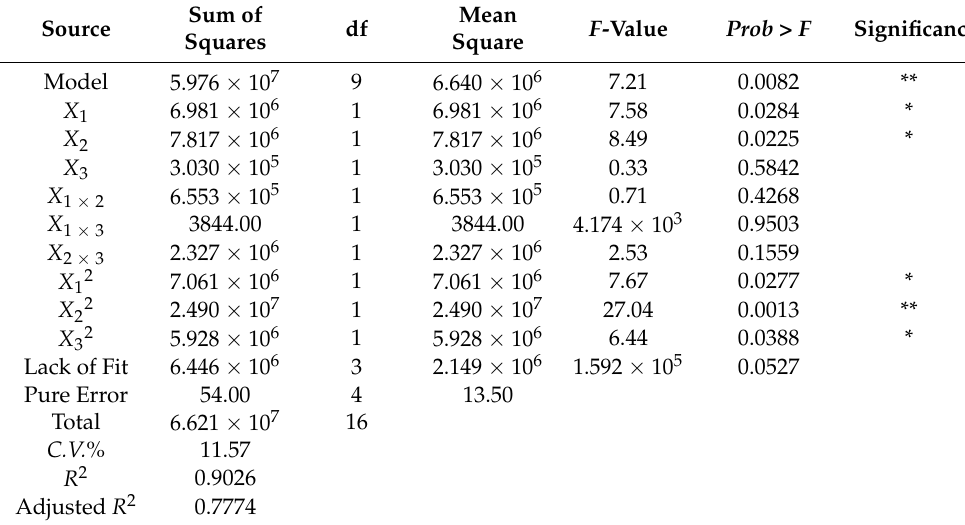
Table 7. ANOVA for Box-Behnken design. Source